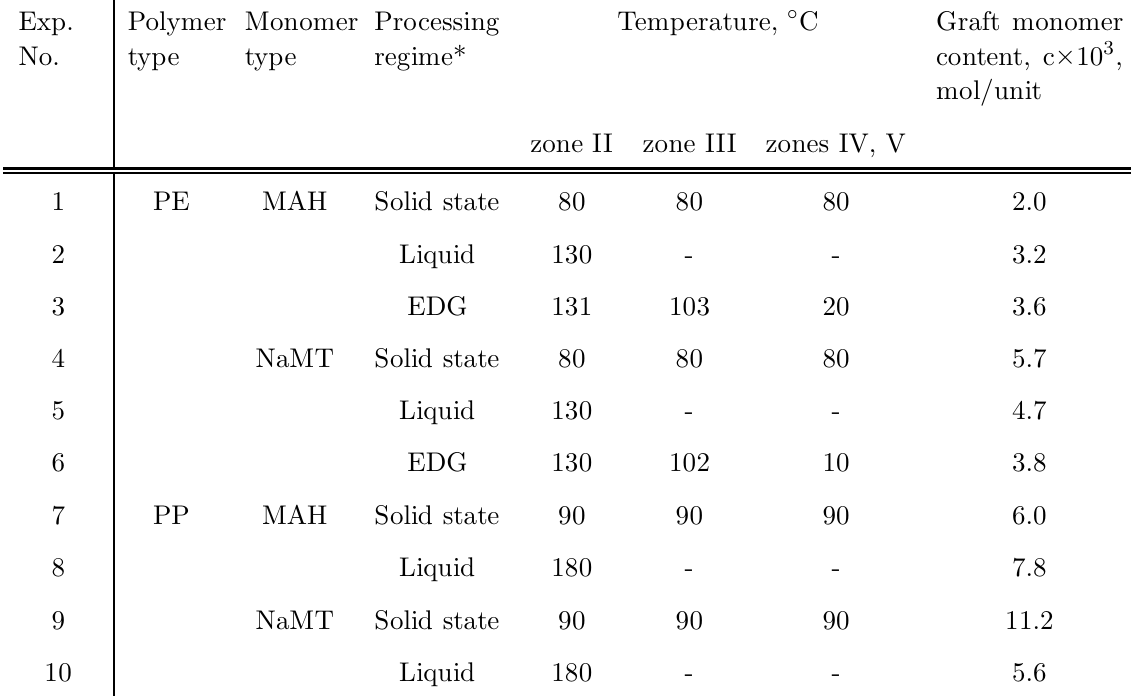
Table 1 Modi› ed PE and PP samples containing 5 % of the modifying agent. NB: MAH- maleic anhydride, NaMT -sodium maleate *10 min. treatment; initiator concentration { 1 wt. %; energy supply rate { 15 J/g x s (for the solid-state and